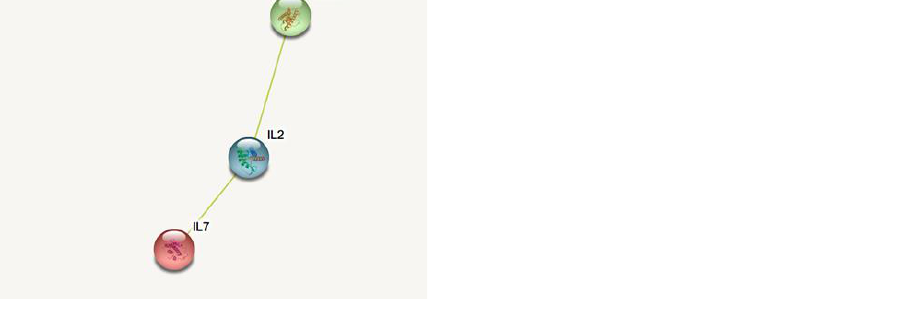
Figure 3. STRING bioinformatic analysis of proteins identified to be over-expressed in bedridden elderly individuals. The protein–protein interaction network was studied and predicted using STRING. The links between the proteins represent possible interactions (line thickness indicates the strength of association and the green line indicates putative text mining associations suggested by further peer-reviewed publications). Table 2. Gene ontology analysis of the biological processes possibly linked to the inflammatory proteins found over-expressed (PDGF-b, CCL4, CCL5, IL-1Ra, CXCL10, CCL2, and IL-9) in the plasma of OLD control individuals compared with age-matched CBR individuals. The list of the main biological processes related to the complex pattern of molecules is reported according to the combined